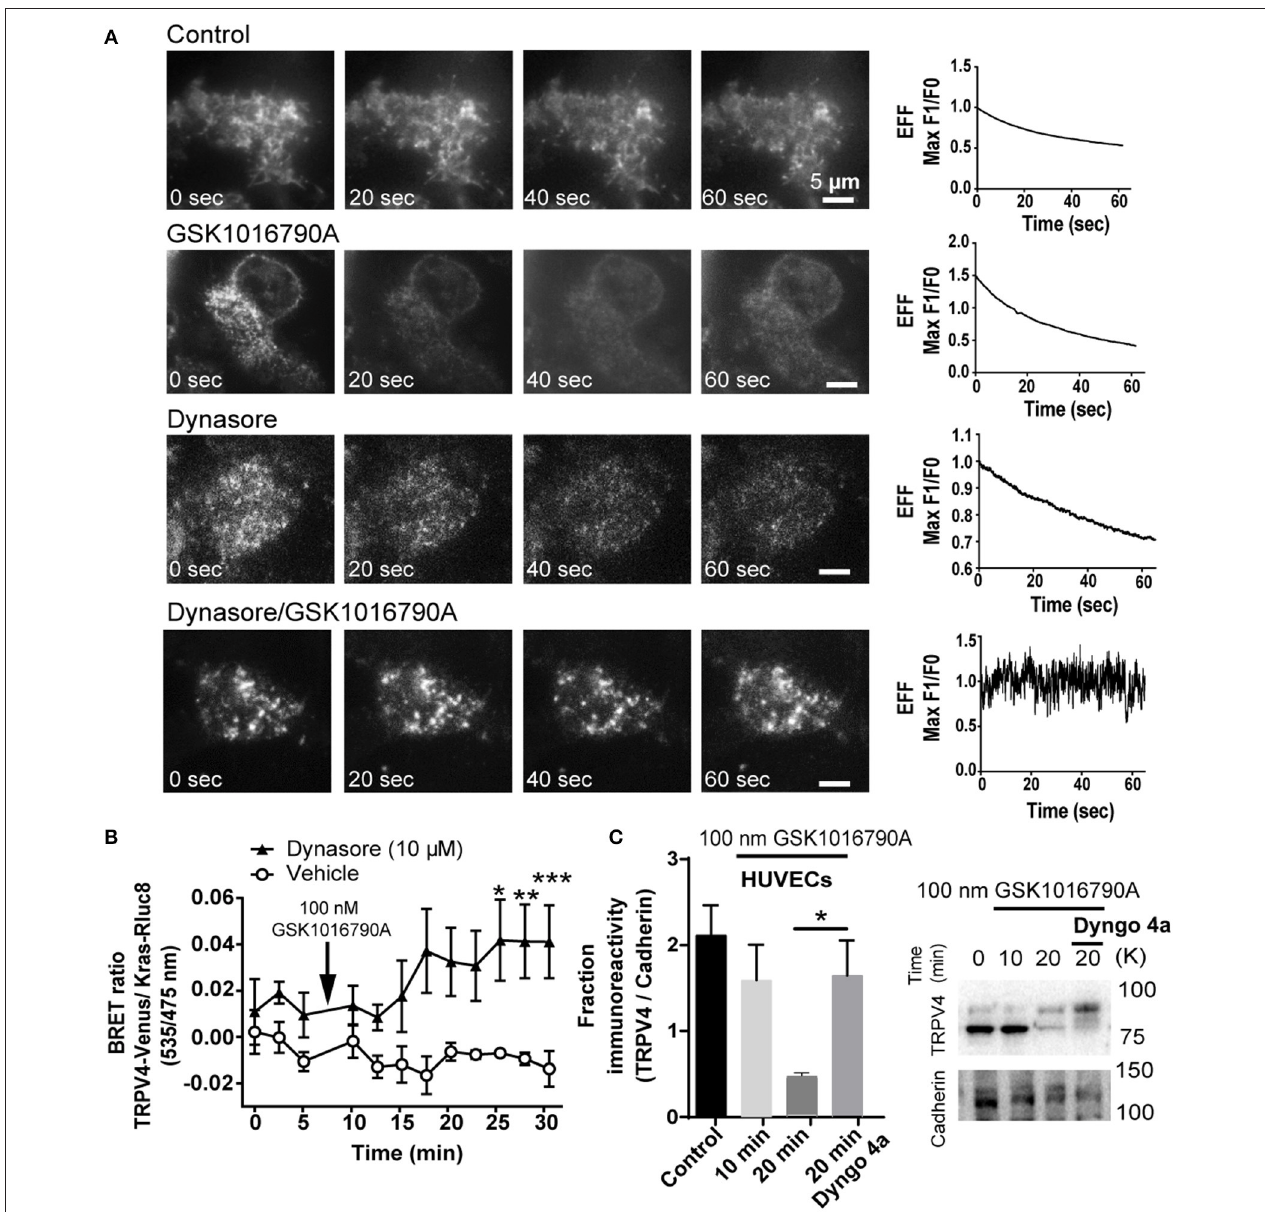
FIGURE 5 | GSK1016790A induced partial fusion of TRPV4 is dynamin dependent (A) TIRF microscopy images showed that inhibition of dynamin blocks the internalization of TRPV4-Venus post-GSK1016790A stimulation while in control groups; untreated, GSK1016790A or Dynasore only treated cells, there is a decrease in the intensity of the TRPV4-Venus fluorescent signal. Graphs represent the evanescence field intensity of the selected cell across the time. (B) BRET data are showing that inhibition of dynamin with 10 µ M of dynasore increased the net BRET ratio between TRPV4 and membrane marker Kras. (C) Cell surface biotinylation assay is showing that inhibition of dynamin with 30 µ M Dyngo4a increased the membrane expression of TRPV4 in HUVECs. TRPV4 on the membrane is expressed in two forms of glycosylated and non-glycosylated. The higher molecular weight band represents the glycosylated form (Lamandé et al., 2011). The graph in (C) represents the average intensity of both bands normalized to the Cadherin, the membrane marker. Data are representative of four independent experiments, and * p < 0.05, ** p < 0.01, and *** p <